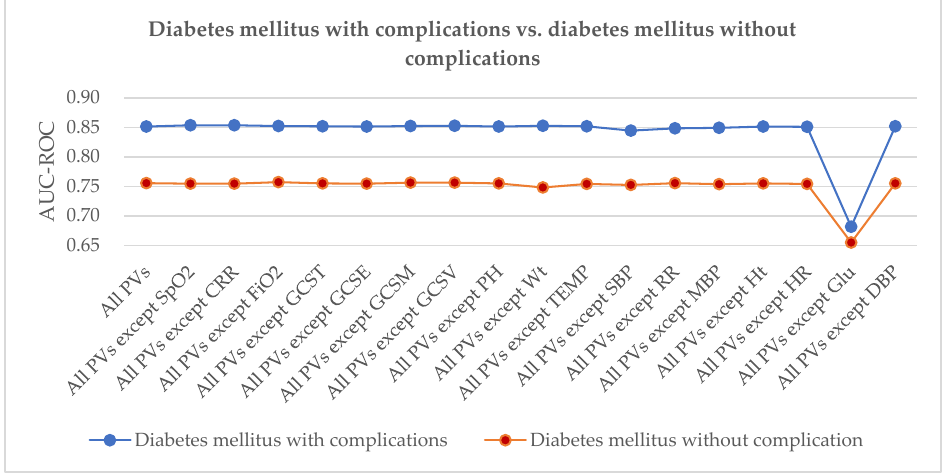
Figure 6. Ranking the importance of PVs (diabetes mellitus with complications vs. diabetes mellitus without complications).